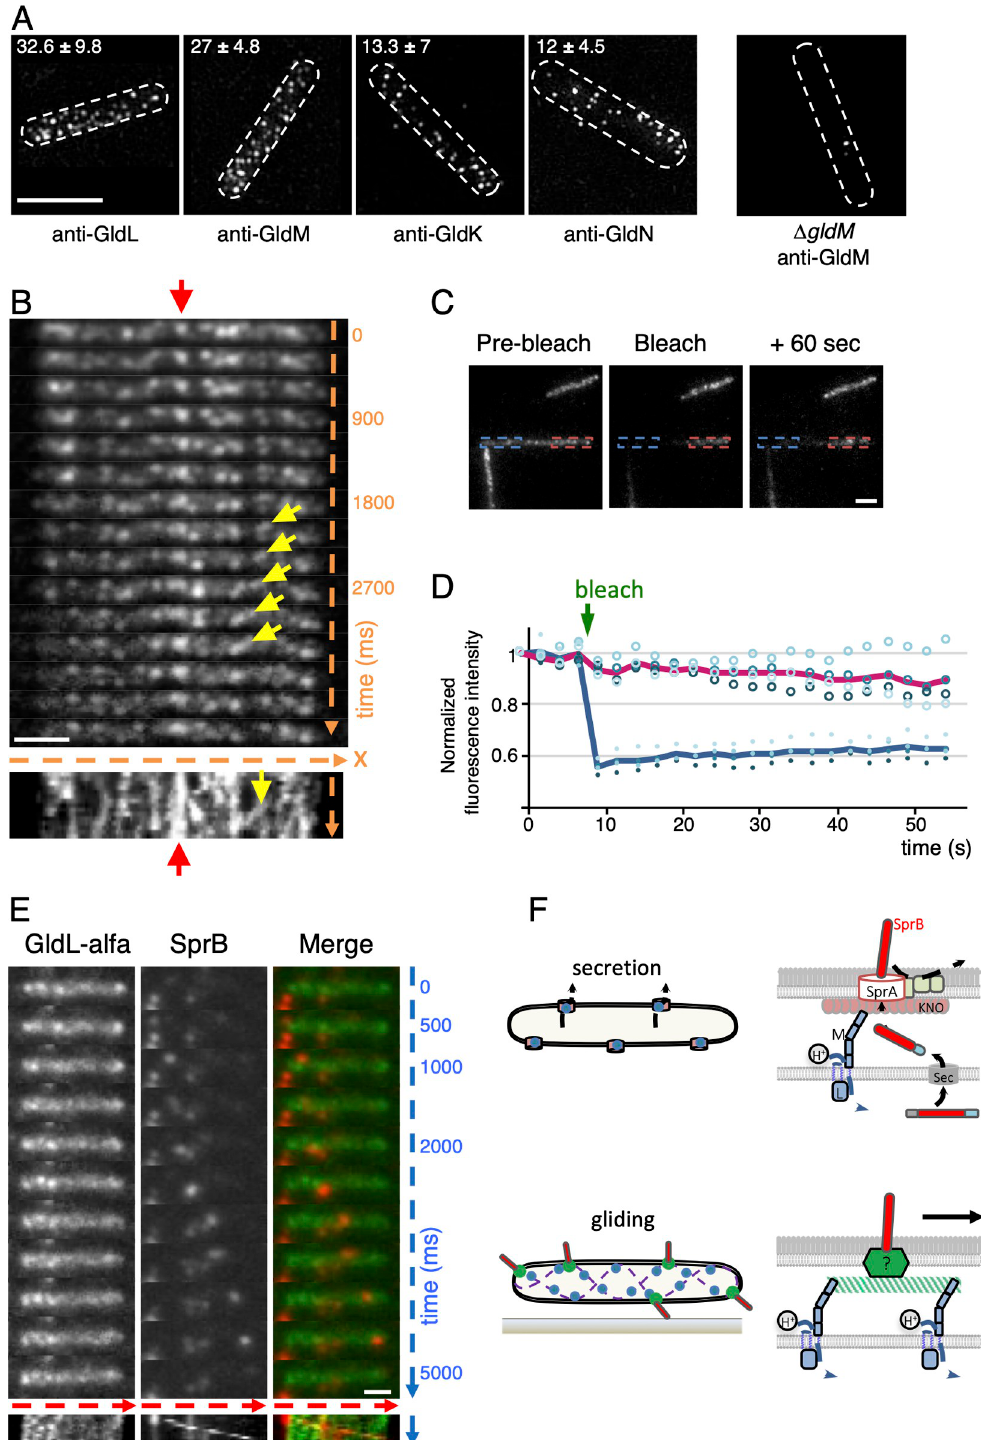
Fig 6. Dynamic localization of Gld complexes. (A) Localization of Gld proteins in fixed cells. Immunostaining of GldL, GldM, GldK, and GldN and observation by SIM. A typical specificity control is shown on the right panel with a Δ gldM mutant stained with antibodies directed against GldM. Scale bar, 2 μ m. The mean number and standard deviation of foci per cell is indicated on top ( n > 10). (B) Live cell dynamics of a functional GldL-alfa fusion bound to NBalfa-sfGFP. NBalfa- sfGFP expression was induced with 1 mM IPTG for 1 hour prior to observation. GldL-alfa dynamics was then followed